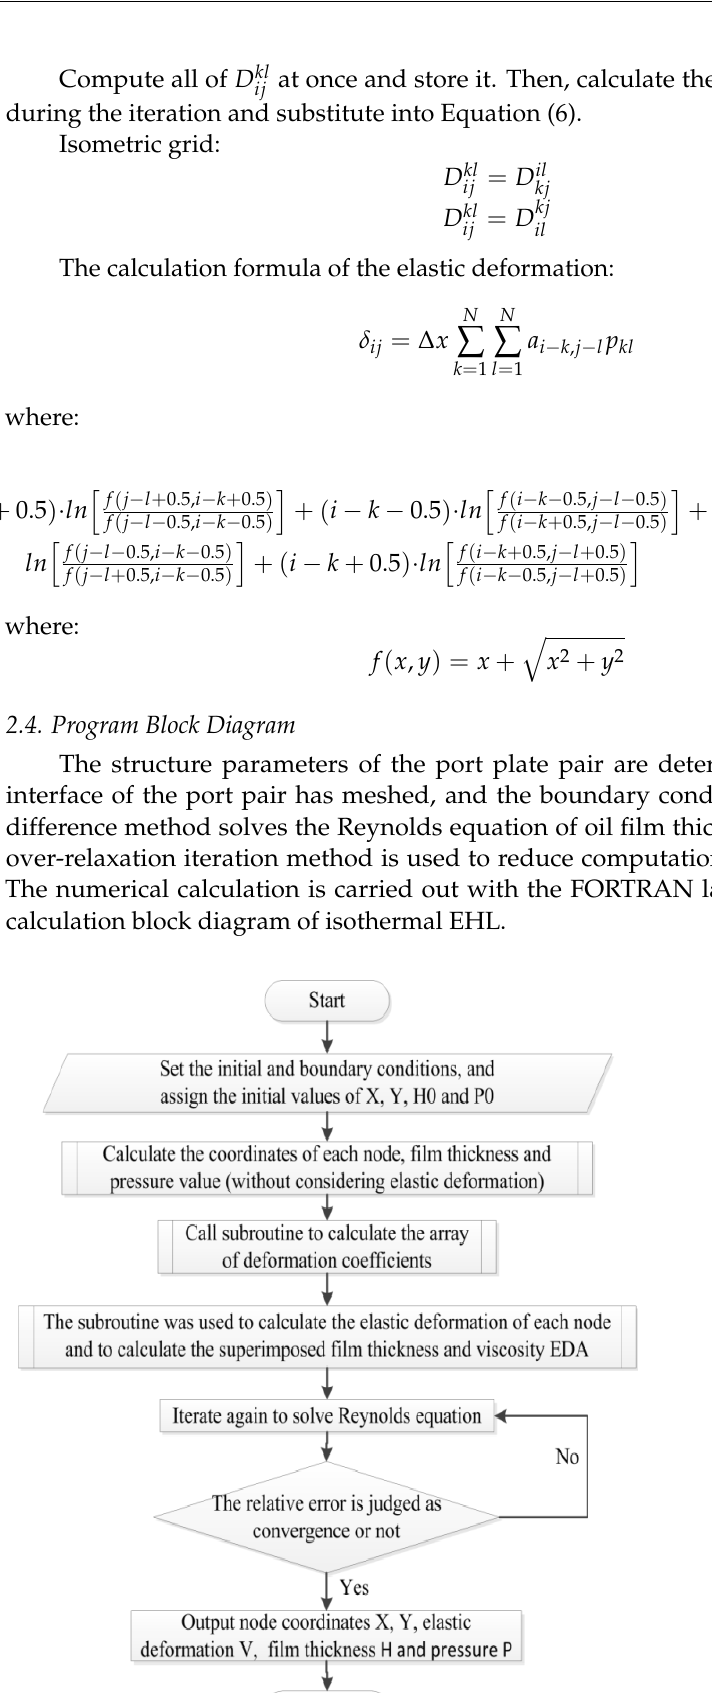
( b ) Figure 4. Oil film thickness distribution: ( a ) three-dimensional diagram of oil film distribution; ( b ) top view of wedge oil film thickness.